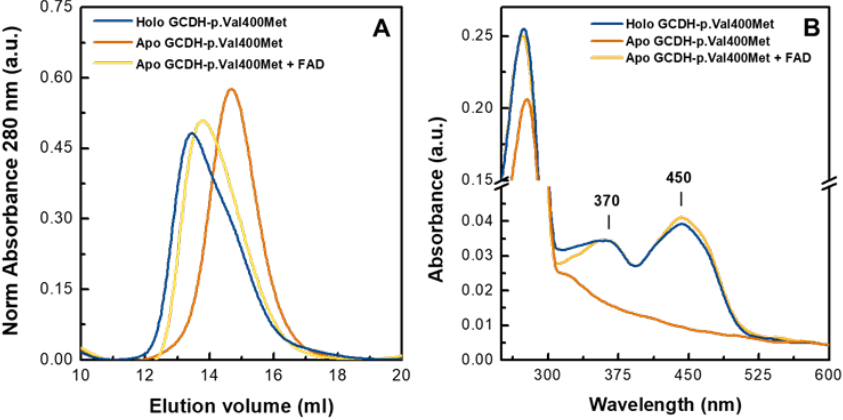
Figure 4. FAD supplementation rescues the folding of the GCDH-p.Val400Met clinical variant. ( A ) Size-exclusion chromatography of GCDH-p.Val400Met samples incubated overnight at 4 °C. Protein solutions were applied into a Superdex 200 10/300 GL column equilibrated in 10 mM HEPES pH 7.8, 150 mM NaCl. Absorbance intensity at 280 nm was normalized in relation to total amount of protein applied. ( B ) UV–visible absorption spectra recorded at room temperature. In both panels, GCDH-p.Val400Met holoprotein—blue line, GCDH-p.Val400Met apoprotein—orange line, and GCDH-p.Val400Met apoprotein + FAD, reconstituted—yellow line.